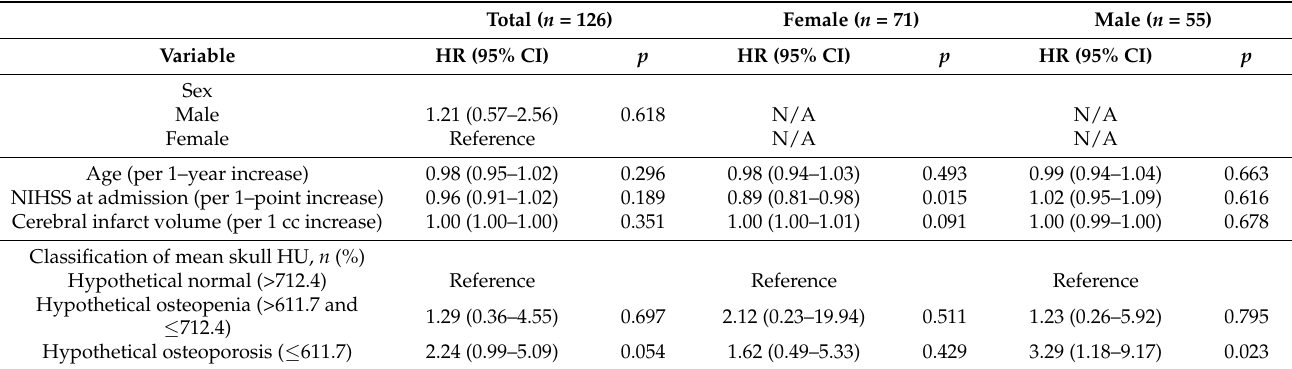
Table 4. Multivariate Cox regression analyses of PH-type HT development after cardioembolic stroke classified by sex in propensity score matched patients (based on the sex, age, stroke severity (NIHSS), and infarction